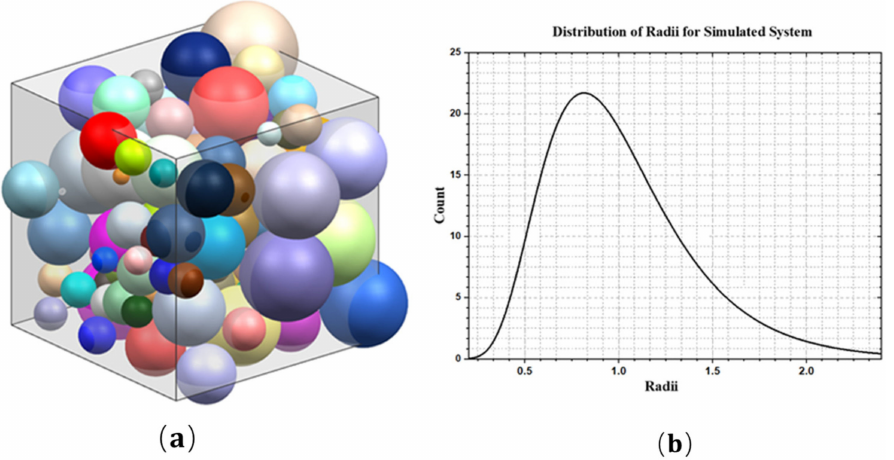
Figure 3. ( a ) Sphere packing of 100 lognormally distributed sphere; ( b ) histogram of radii plotted the lognormal